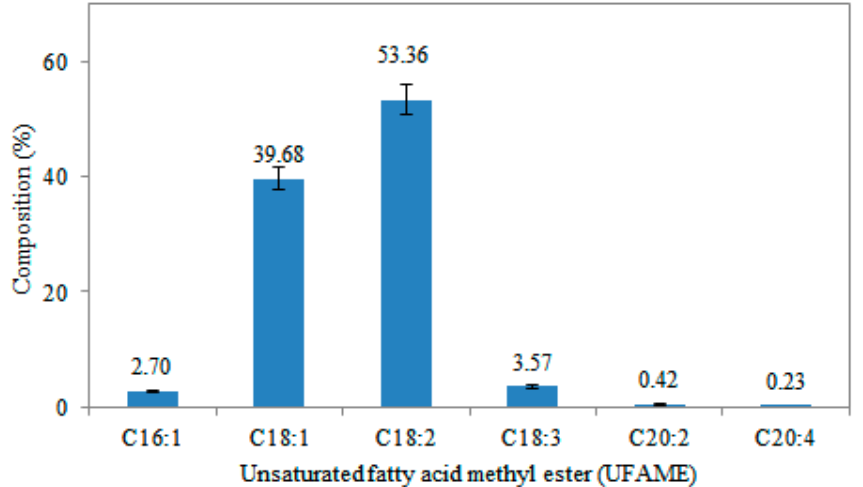
Figure 2. Unsaturated fatty acid methyl ester composition of Chlorella vulgaris microalgae. The bars indicate significant di ff erences at p < 0.05.